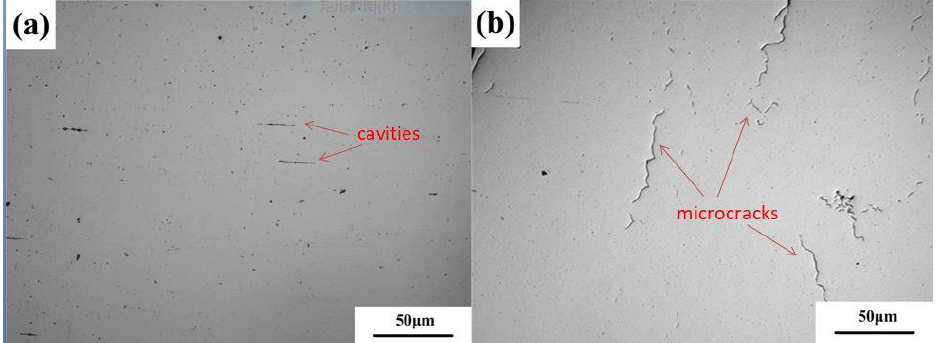
Figure 4. Development of microcracks during the hot compression process at 1150 °C. ( a ) ε = 0.2, ( b ) ε = 0.5.